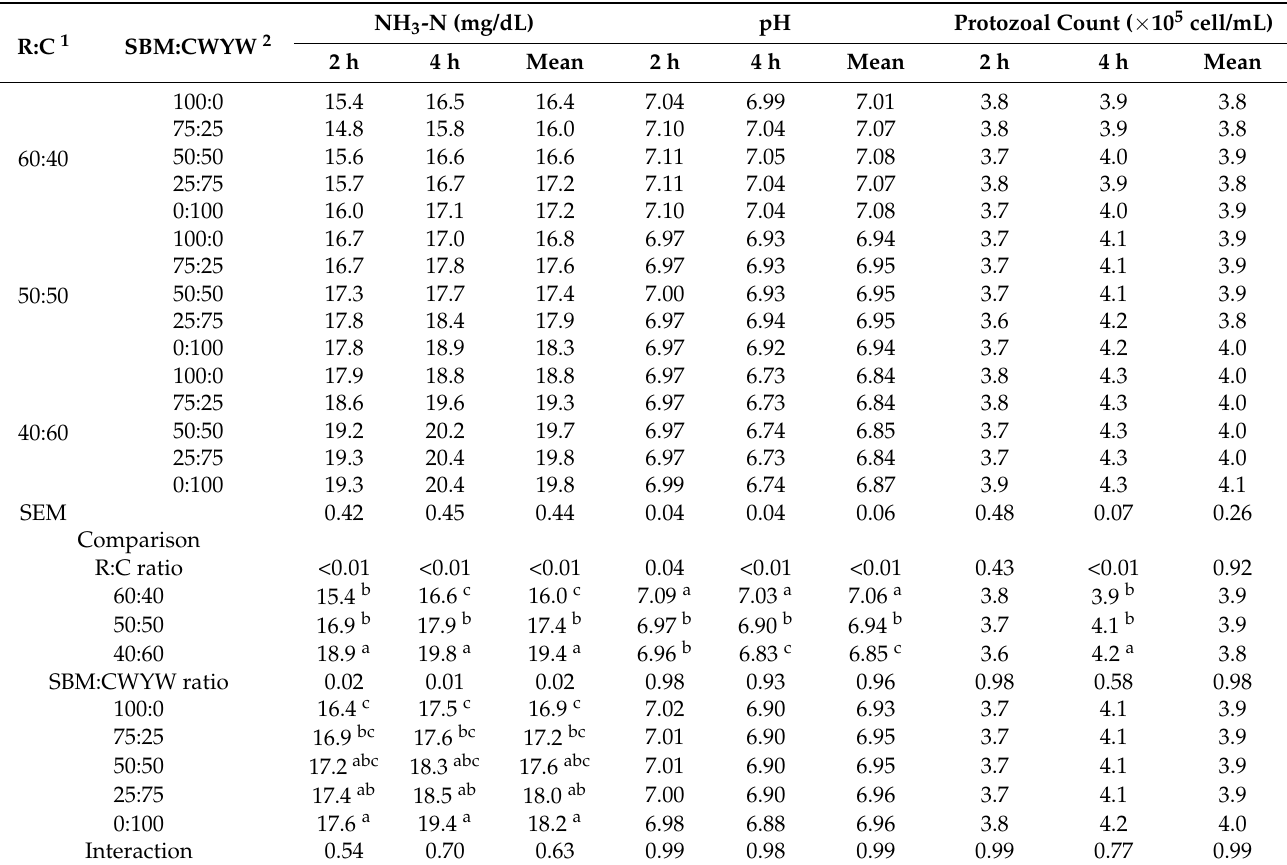
Table 4. Effect of R:C ratio level combined with SBM:CWYW ratio level on ruminal NH 3 -N, pH and protozoal